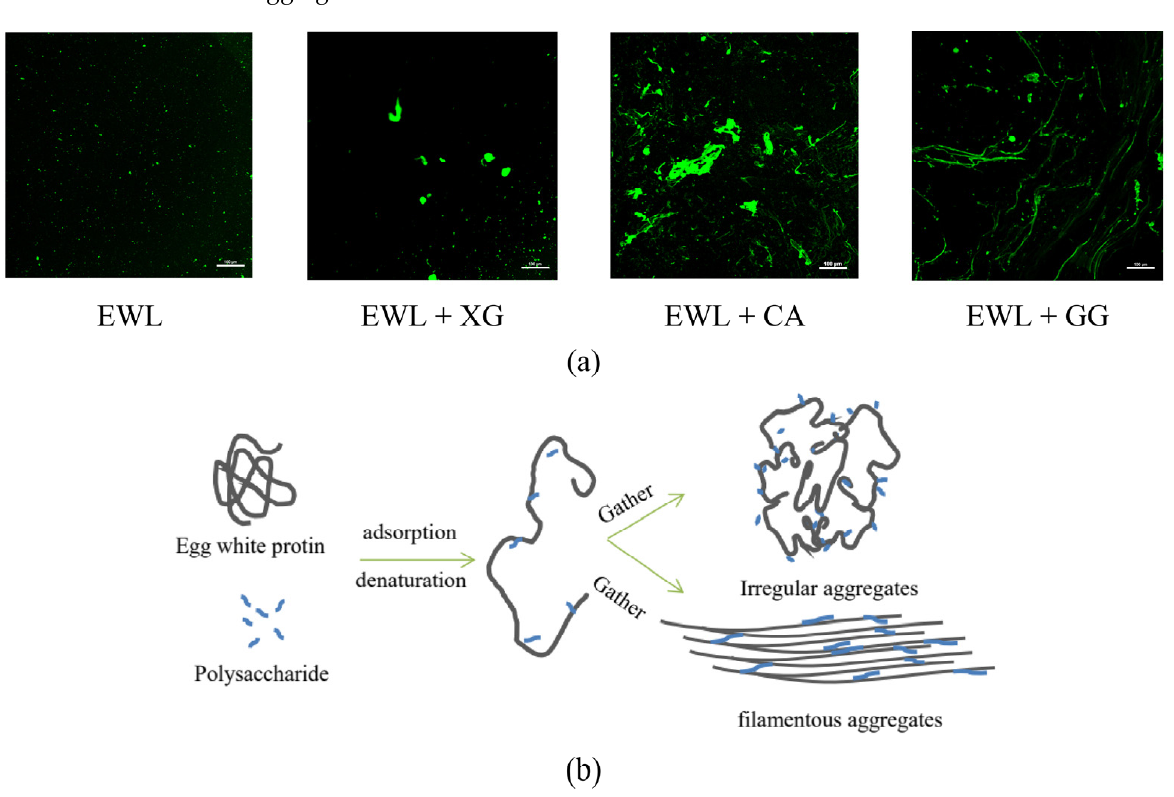
Figure 9. ( a ) Effects of polysaccharide added to egg white liquid on microscopic images. ( b ) Electro- static interaction and hydrogen bonding between polysaccharides and egg white protein.